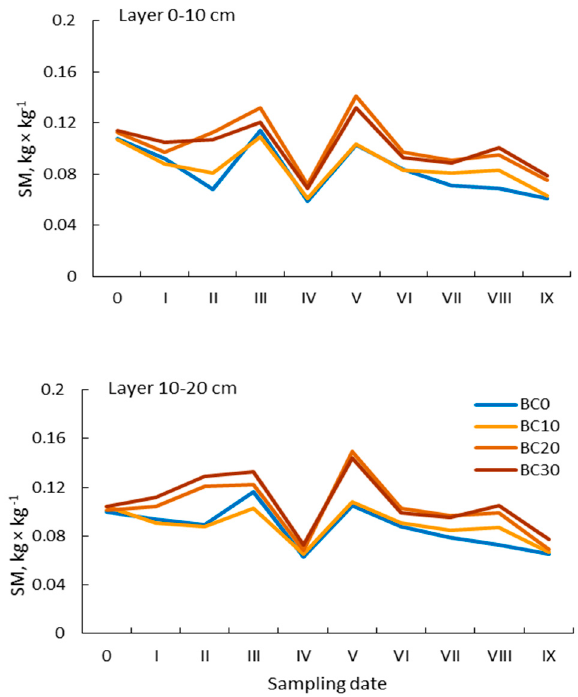
Figure 6. Soil moisture at sampling (SM). Explanations as for Figure 1.